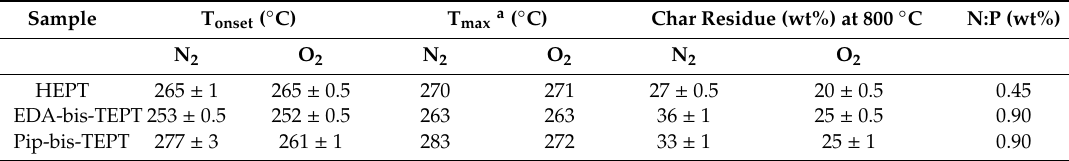
Figure 2. Thermal gravimetric analysis (TGA) ( a ), and derivative thermogravimetry (DTG) ( b ) plots of the organophosphorus-based bridged triazine derivatives under an N 2 atmosphere. Table 2. Thermal gravimetric analysis (TGA) data of the synthesized compounds.